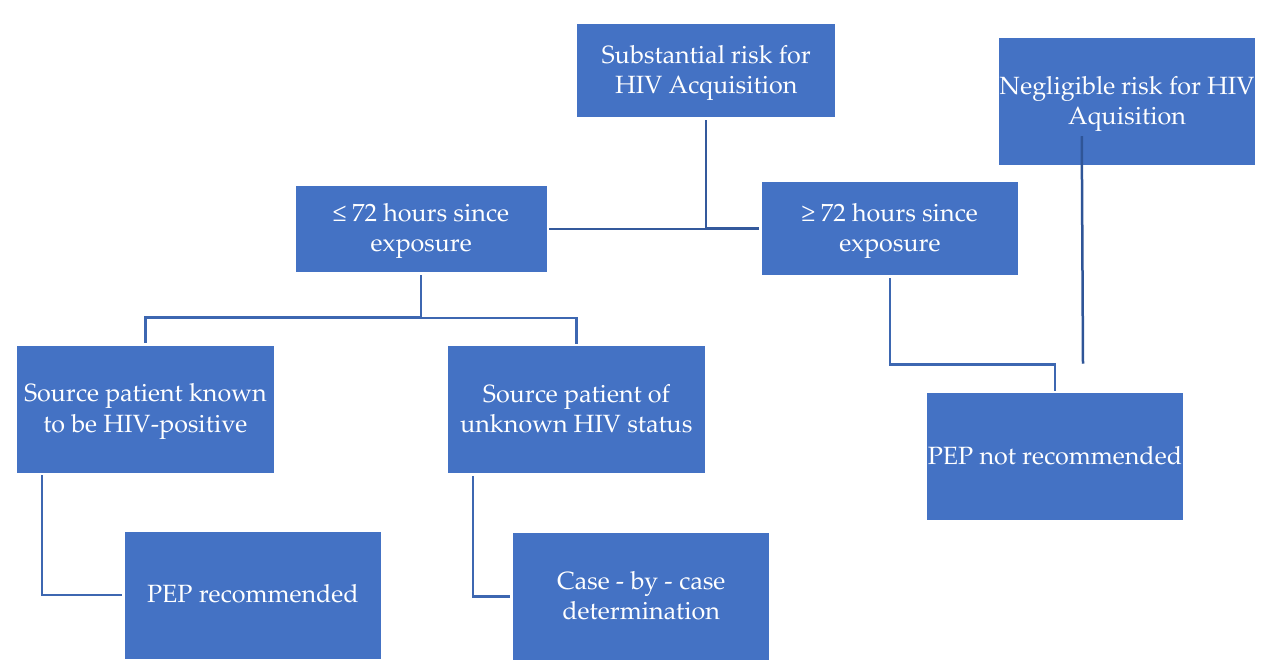
Figure 1. Algorithm for evaluation and treatment of possible non-vertical exposure to HIV [27]. Table 8. Substantial and negligible risk scenarios for HIV Acquisition according to CDC guidelines [27]. Substantial Risk for HIV Acquisition Negligible Risk for HIV